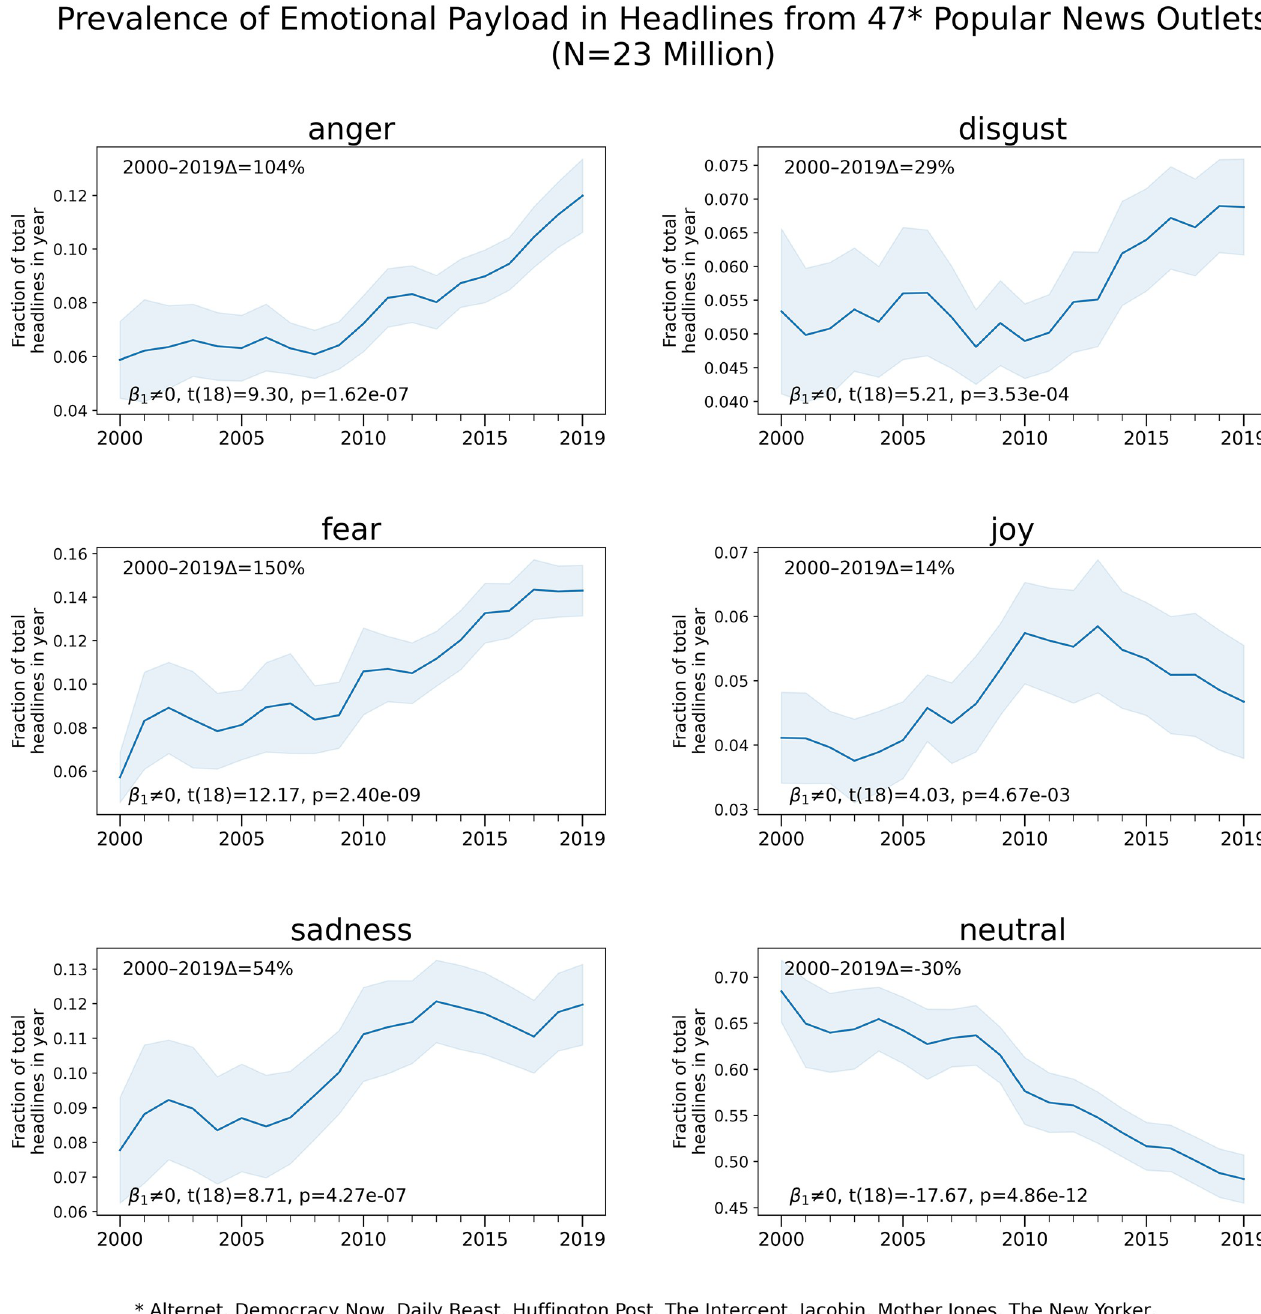
Fig 3. Average yearly prevalence of news articles headlines denoting different types of emotionality in 47 popular news media outlets. The shaded gray area indicates the 95% confidence interval around the mean. Note the different scale of the Y axes for the different emotion types. For each emotional category, statistical tests for the null hypothesis of zero slope are shown on the bottom left of each subplot. Reported p-values have been Bonferroni-corrected for multiple comparisons. The percentage changes between 2000 and 2019 are shown on the top left of each subplot.